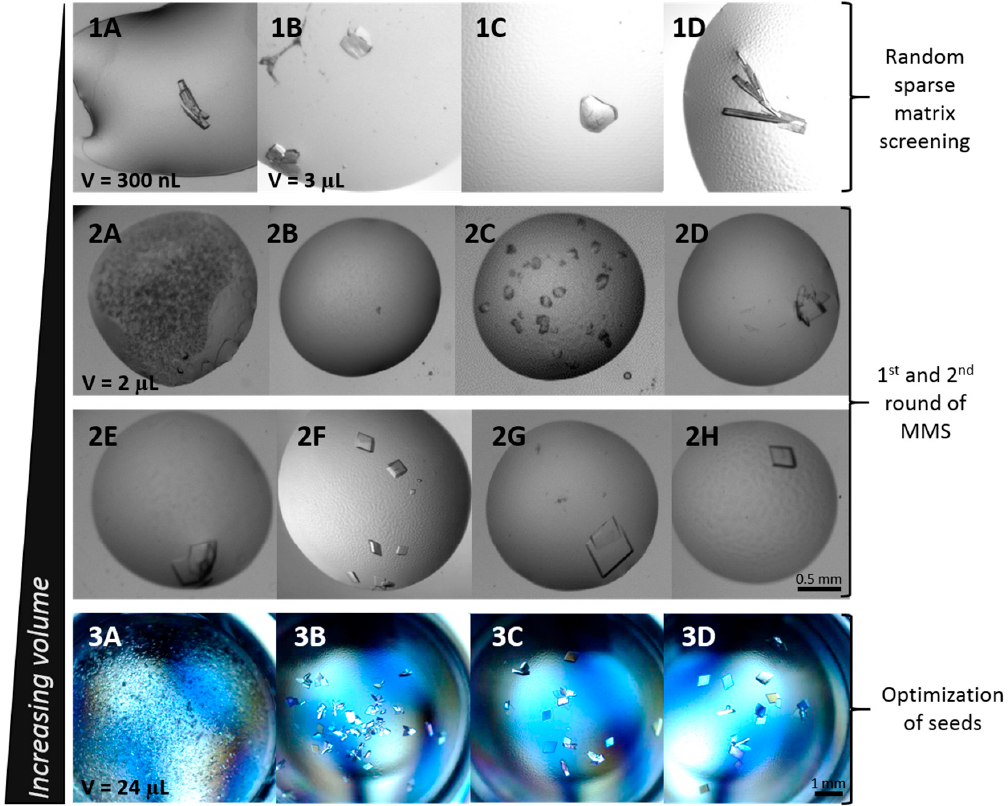
Figure 2. Crystallization of CA IX SV from initial hit to optimized crystals used for diffraction. Drop